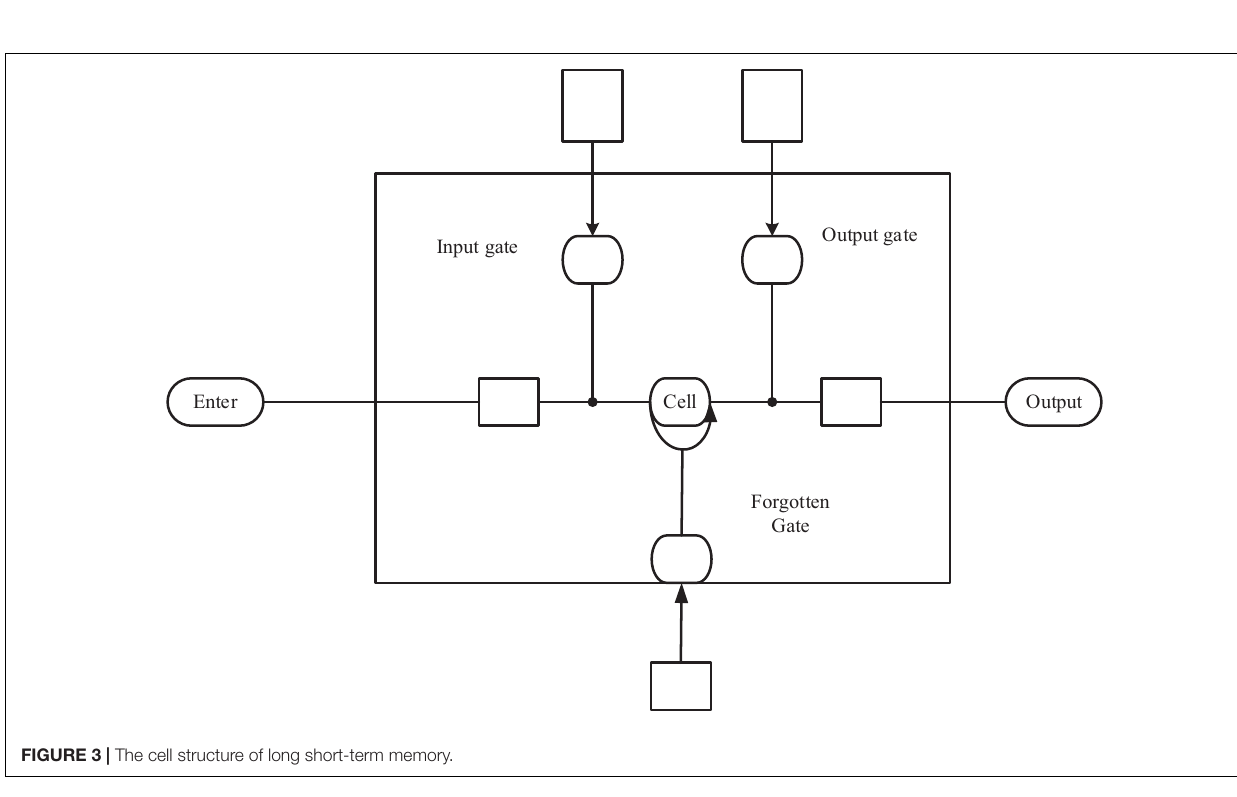
FIGURE 3 | The cell structure of long short-term memory.